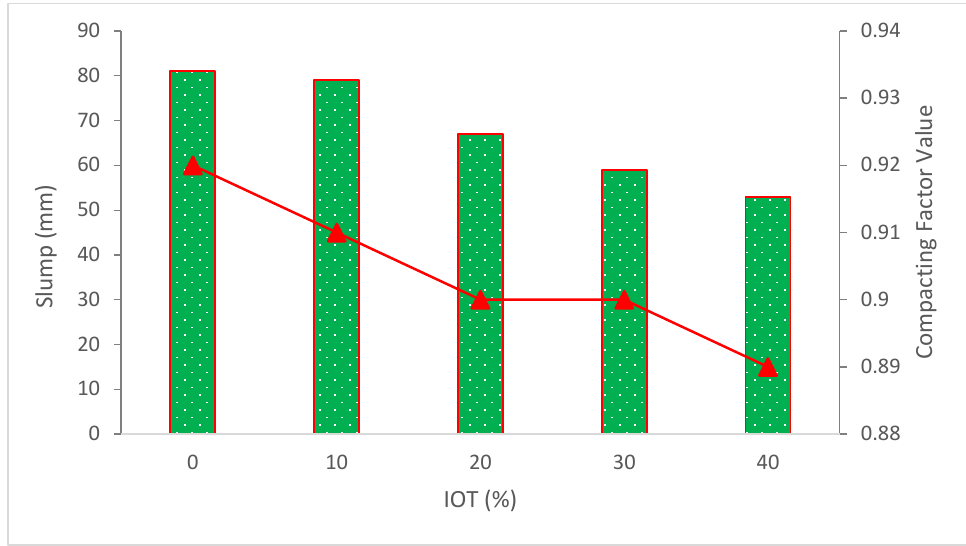
Figure 7. Compacting factor results (data source [57]).